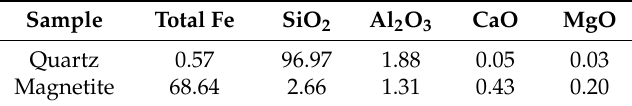
Table 1. Chemical composition of the pure minerals (wt %).